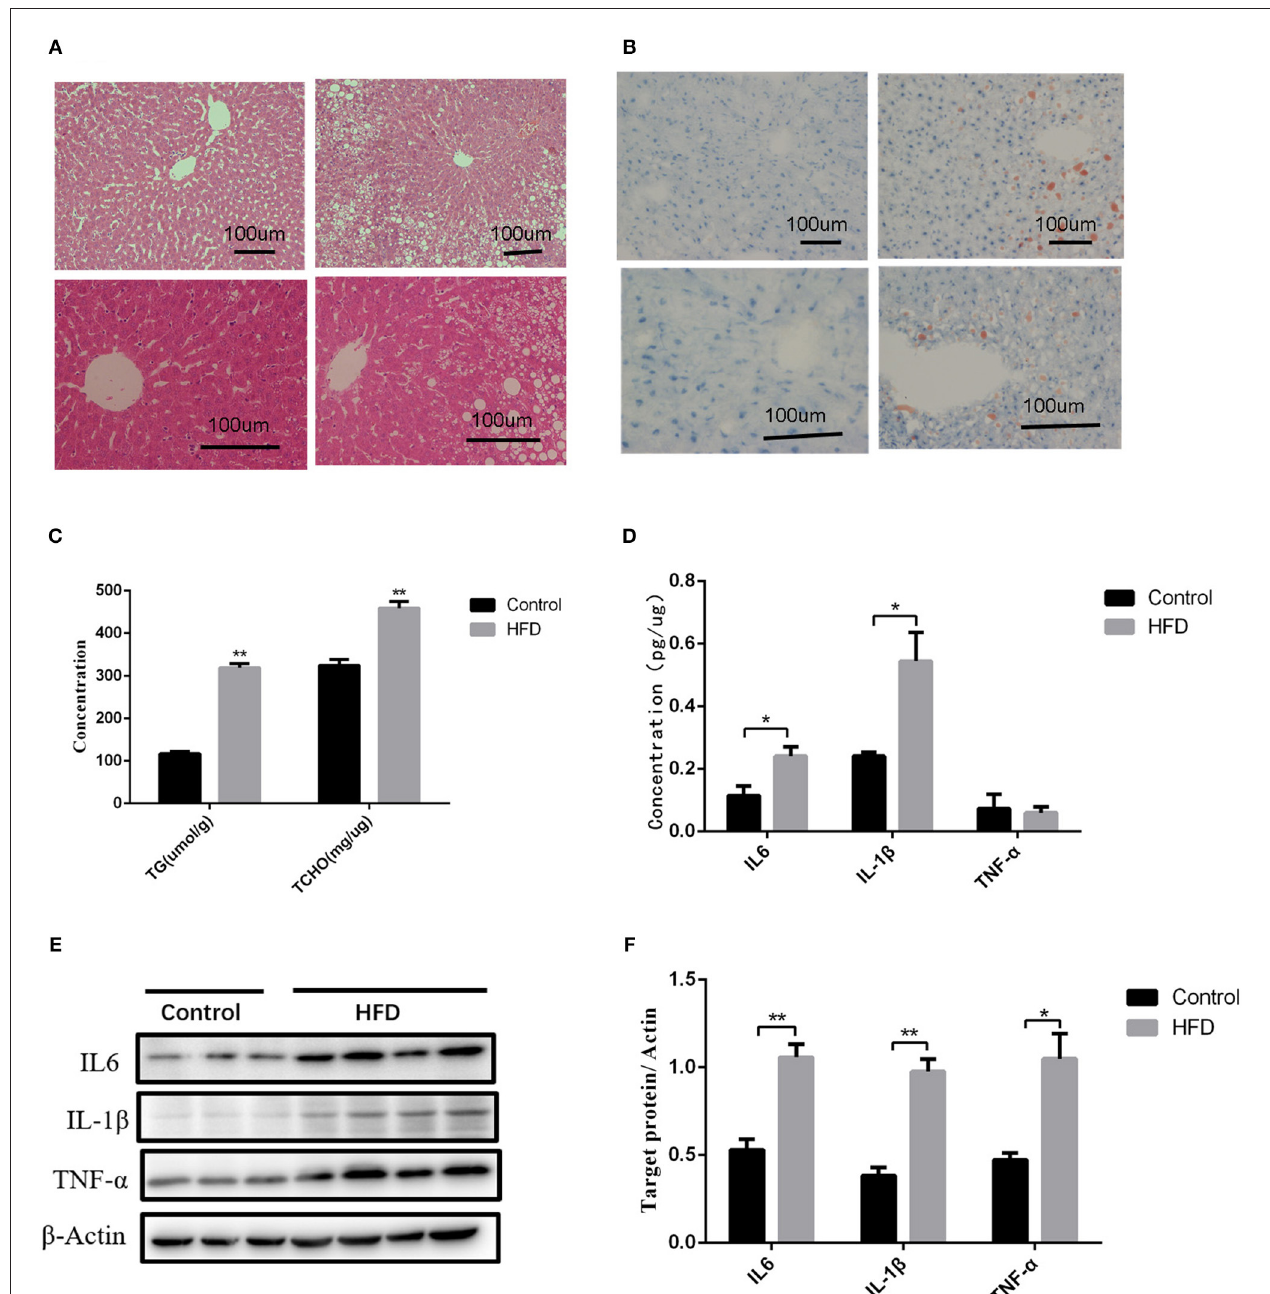
FIGURE 2 | Liver pathology and inflammation status in the placental and umbilical cord in maternity dams. (A) Hematoxylin and eosin (H&E) staining of livers from F0-CON dams [(a): 200X; (b): 400X] and F0-HFD dams [(c): 200X; (d): 400X] after full-term pregnancy. (B) Oil red O staining of livers from F0-CON dams [(a): 200X; (b): 400X] and F0-HFD dams [(c): 200X; (d): 400X] after full-term pregnancy. (C) Comparison of hepatic TG and TCHO levels between F0-CON and F0-HFD dams after full-term pregnancy. (D) Comparison of cytokines in umbilical cord blood between F0-CON and F0-HFD dams by ELISA. (E) Cytokine protein levels in placental tissues between F0-CON and F0-HFD dams. (F) Comparison of cytokine protein levels in placental tissues between F0-CON and F0-HFD dams. ** P < 0.01; * P < 0.05.